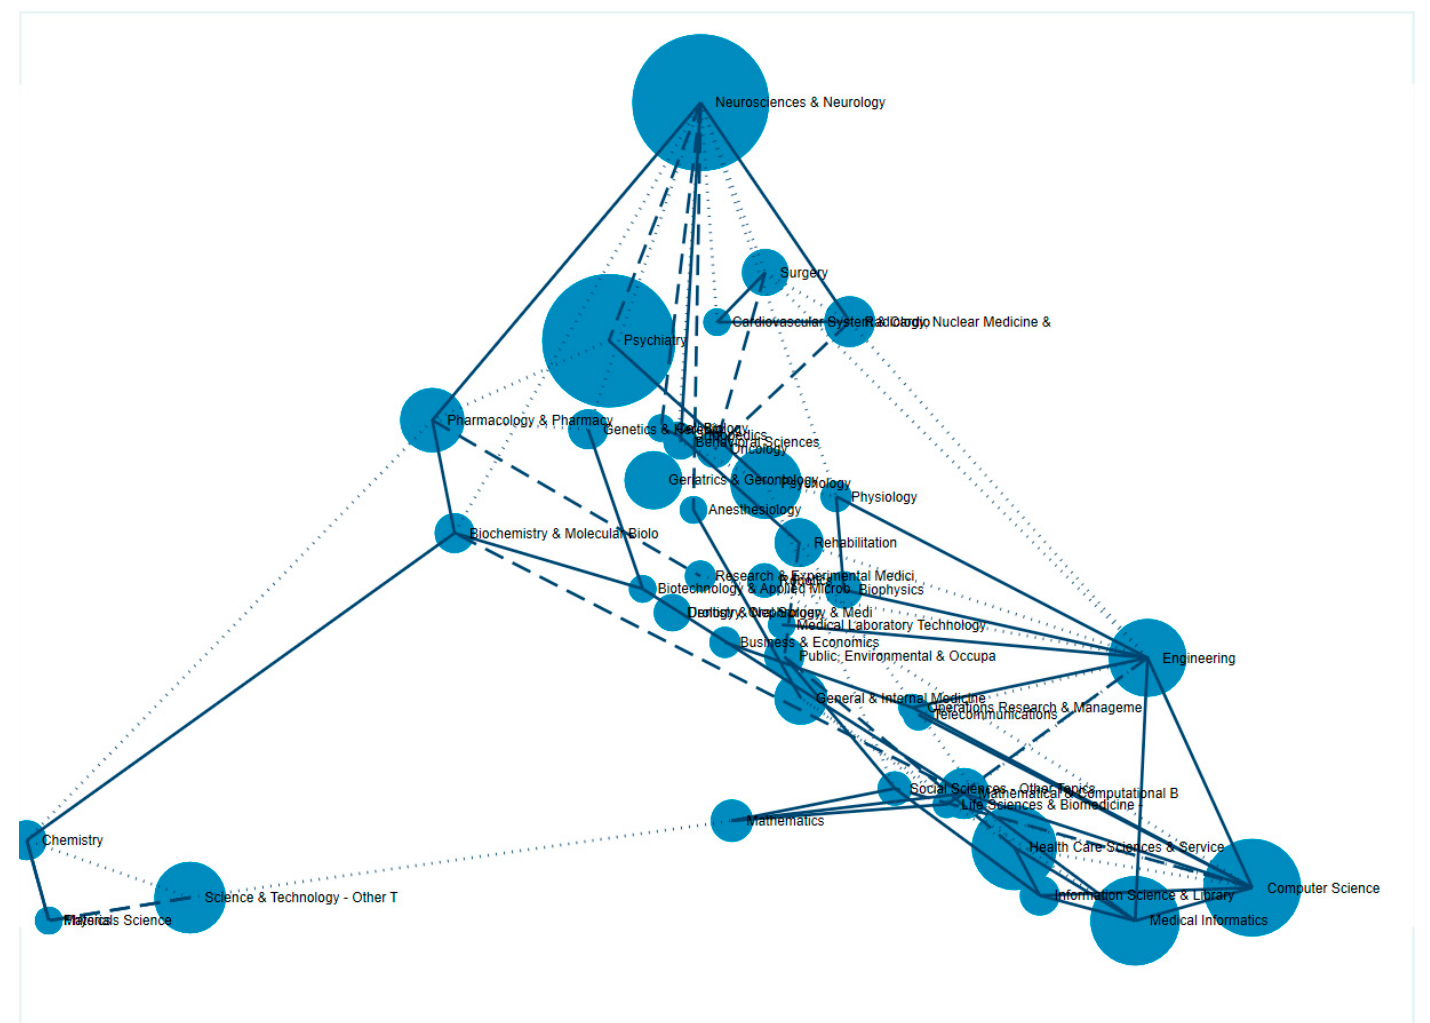
Figure 5. Coincidence of research areas using the Web of Science classifications.